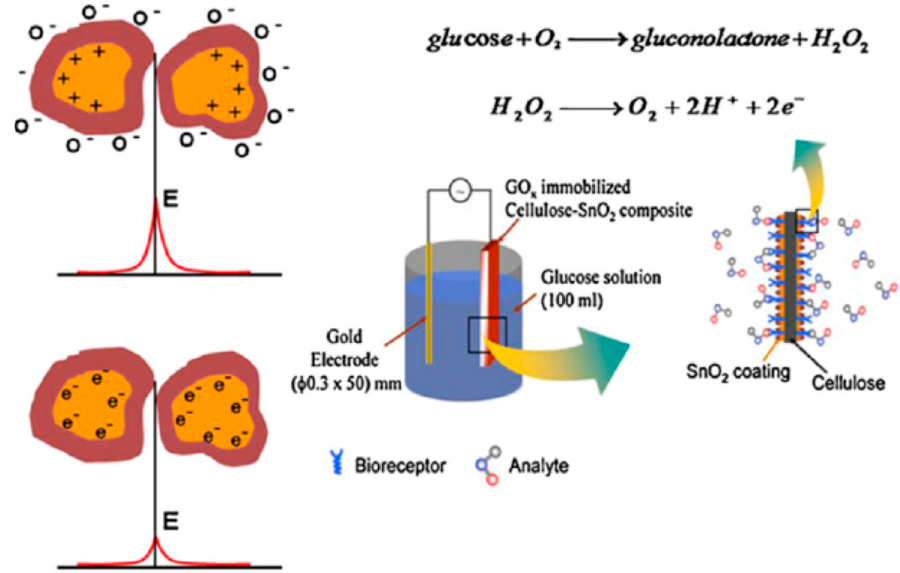
Figure 13. Schematic representation of the detection mechanism of a cellulose-SnO 2 hybrid nanocomposite glucose biosensor [111].